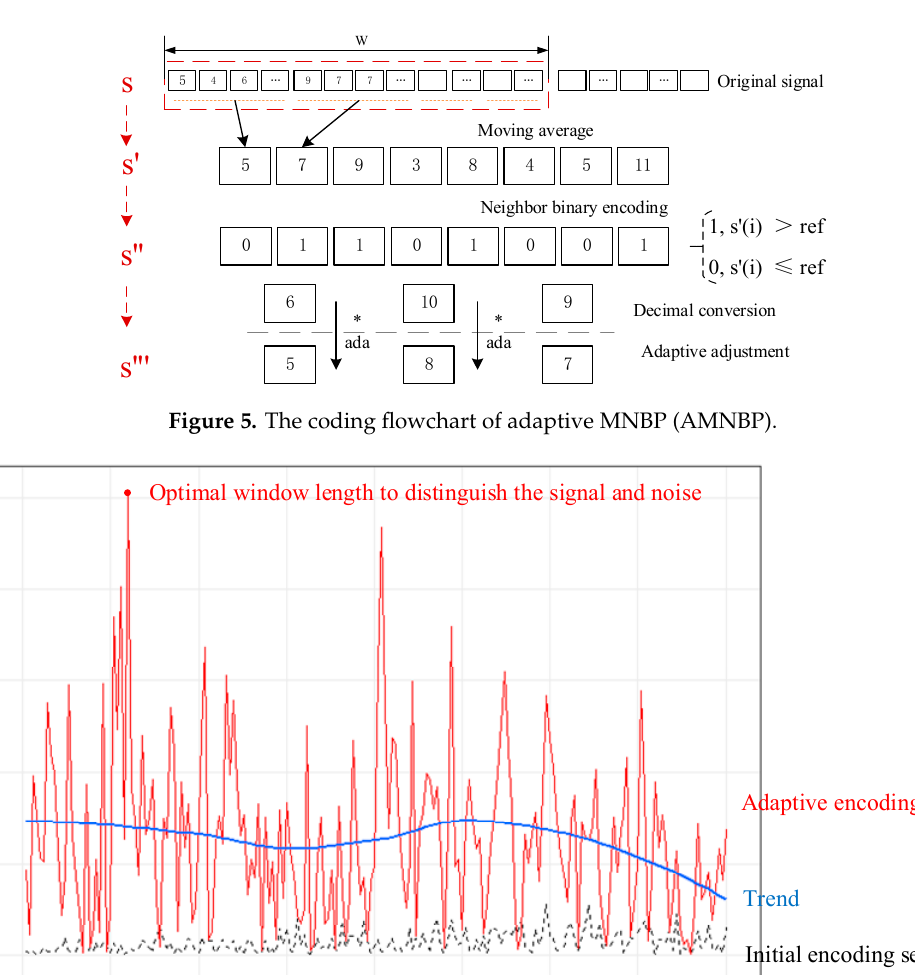
Figure 5. The coding flowchart of adaptive MNBP (AMNBP).